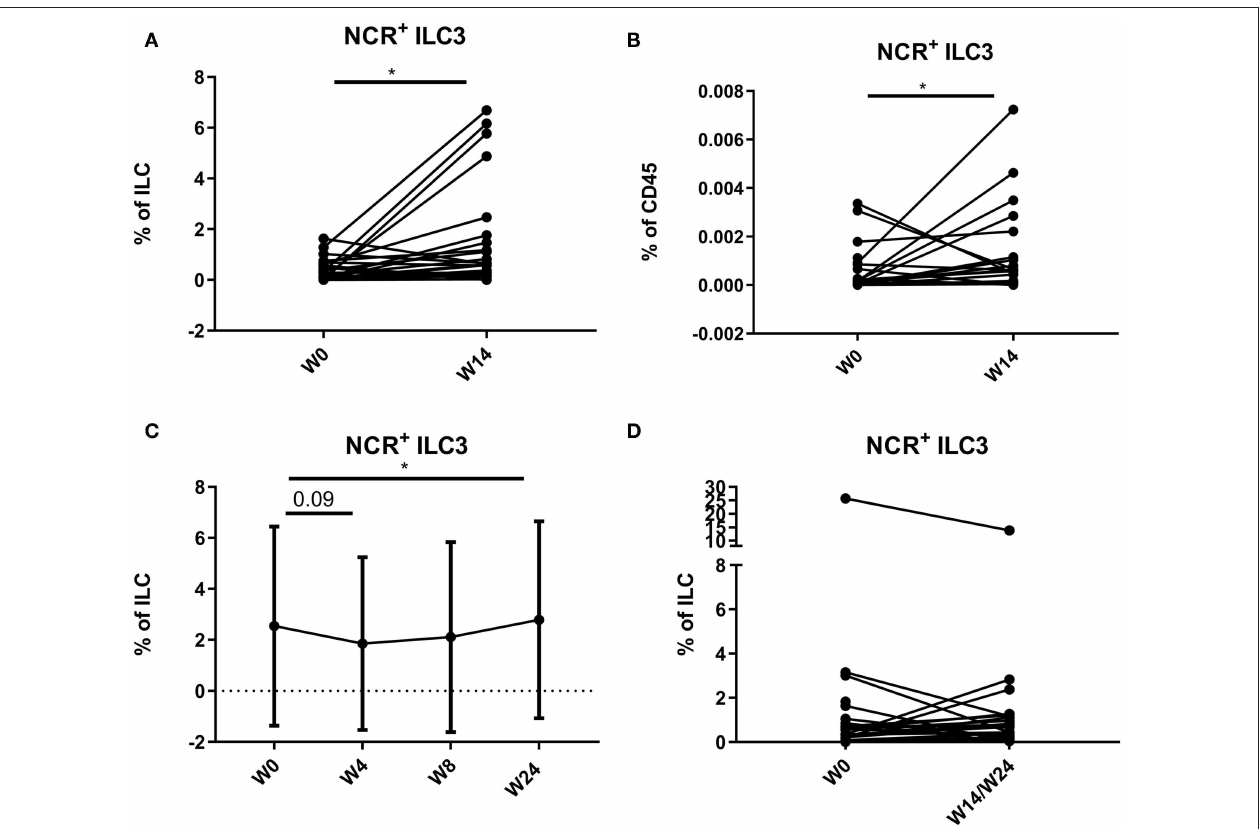
FIGURE 9 | Mobilization of NCR + ILC3 in the circulation of patients treated with anti-TNF, ustekinumab, or vedolizumab. Paired analysis of NCR + ILC3 as proportion of total ILC (A) and of total leukocytes (B) in anti-TNF–treated patients before and after treatment. Follow-up of NCR + ILC3 as proportion of total ILC in ustekinumab (C) –treated patients. Paired analysis of NCR + ILC3 as proportion of total ILC in vedolizumab (D) –treated patients before and after treatment. Wilcoxon paired-match testing; * p < 0.05. NCR, natural cytotoxic receptor; ILC, innate lymphoid cell. this. We detected NKp44 + ILC3 in the circulation of 15% of CD patients, although they are absent in all UC patients and HCs. Presence of these NKp44 + ILC3 cells in the circulation did not correlate with disease severity or extraintestinal